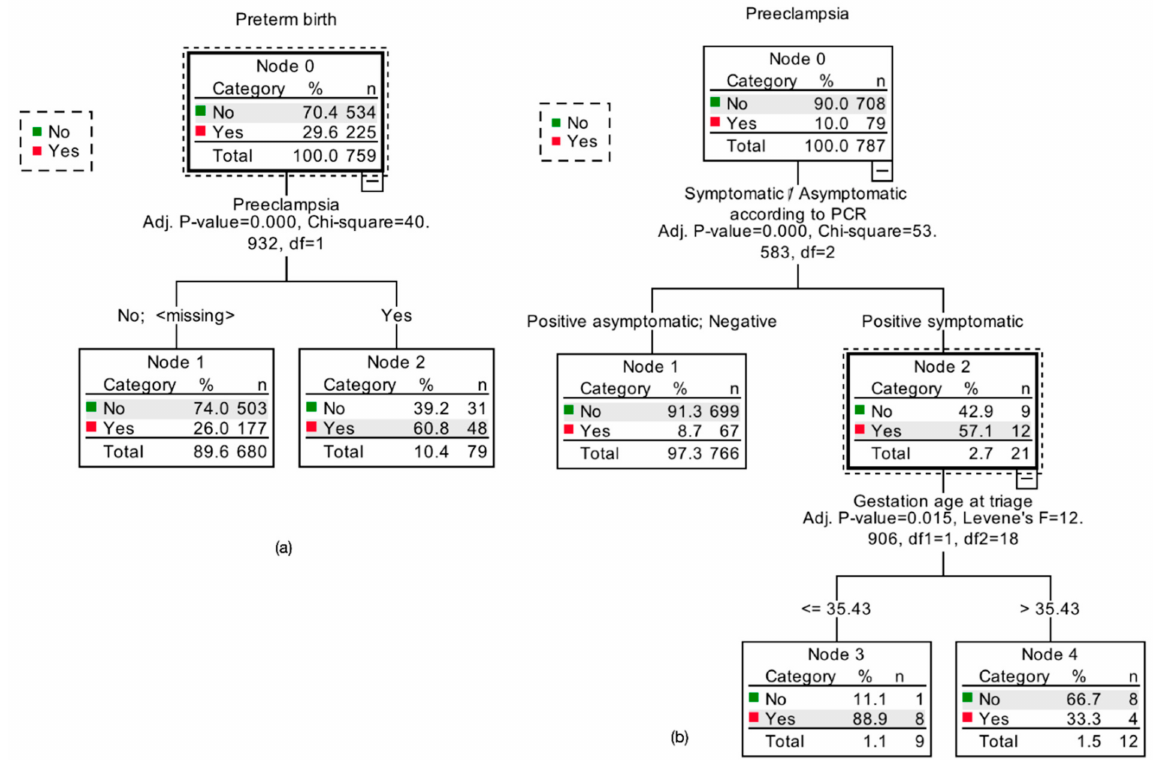
Figure 6. QUEST trees for preterm birth ( a ) and preeclampsia ( b ). QUEST for preterm birth had only one split. Preterm birth was highly related to the development of preeclampsia; the terminal node of the tree shows that 60.8% of women who developed preeclampsia had preterm birth, whereas in women who did not develop preeclampsia, only 26% delivered preterm ( a ). QUEST for preeclampsia had two splits. Preeclampsia was present in 8.7% of women who tested negative or were positive asymptomatic, but 57.1% of positive and symptomatic women developed preeclampsia. Moreover, the terminal node shows that women who developed COVID before or at week 35 and who were symptomatic were more likely to develop preeclampsia